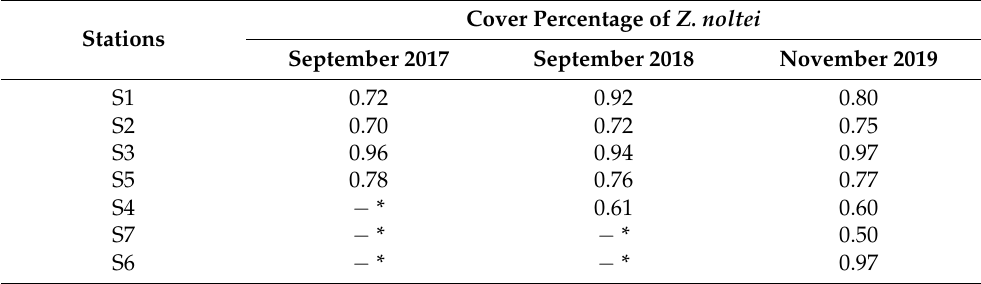
Table 4. Cover percentage of Z. noltei per station in the Merja Zerga (stations S1, S2, S3, S4, S5, S6, and S7; *: insufficient quadrats.